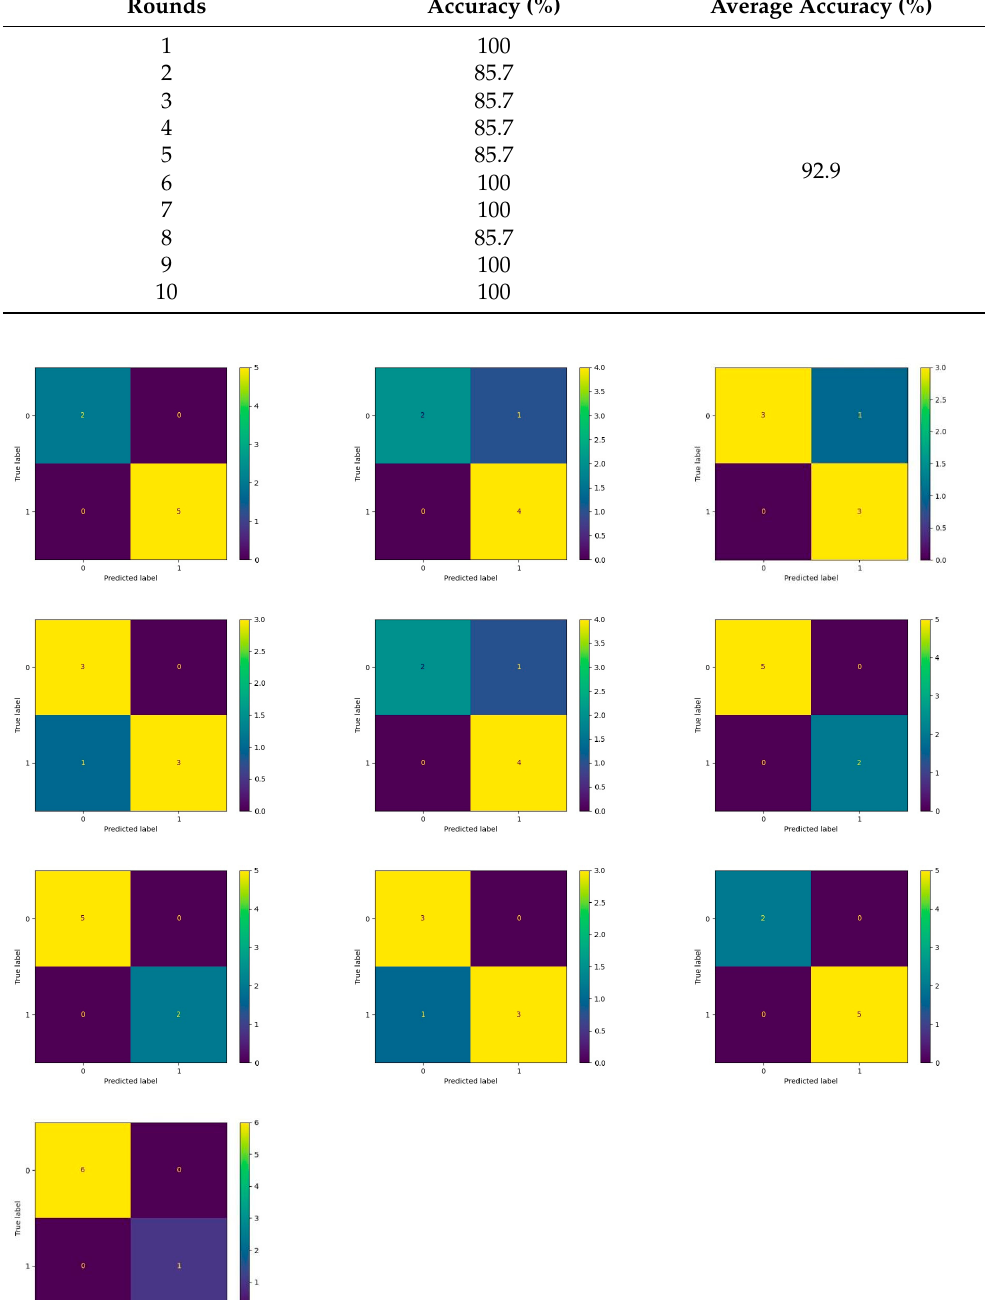
Figure 5. The obfuscation matrix of identification tests performed 10 times between food and medicine. The horizontal and vertical coordinates, respectively, represent the predicted and real years of ginseng, and 0 is ginseng at 1–5 years, and 1 represents ginseng at 6–7 years. The values on the diagonal refer to the number of correct label predictions; other values that are not on the diagonal include the number of labels that are incorrectly predicted for the corresponding year label. Table 3. The recognition accuracies under food or medicine classification scale.